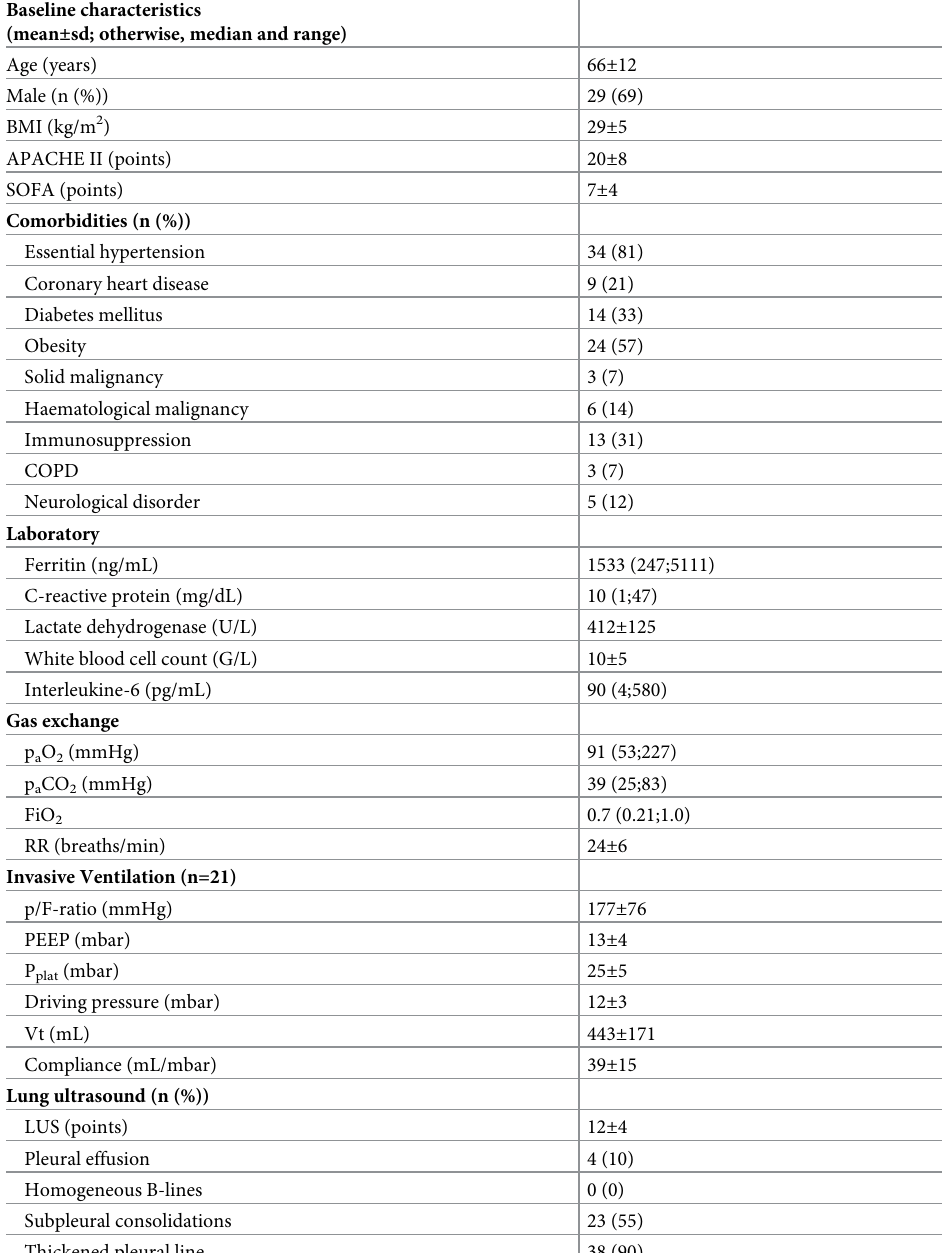
Table 2. Baseline characteristics. Baseline characteristics (mean ± sd; otherwise, median and